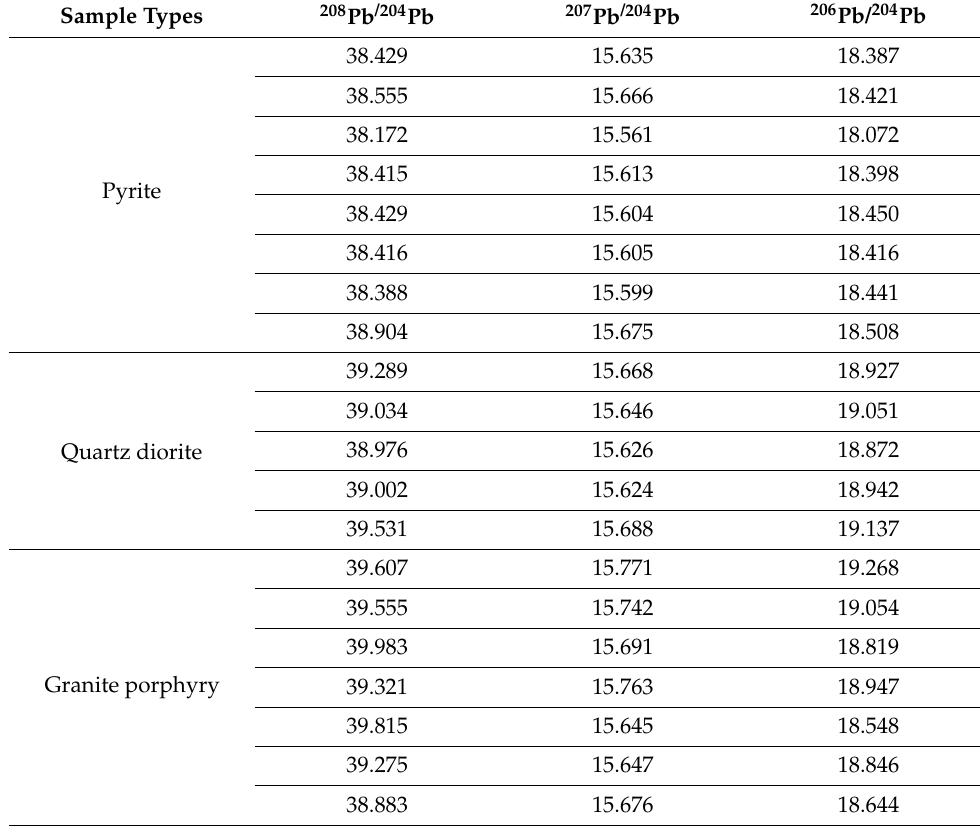
Table 5. Lead isotopic compositions of Asiha complex and